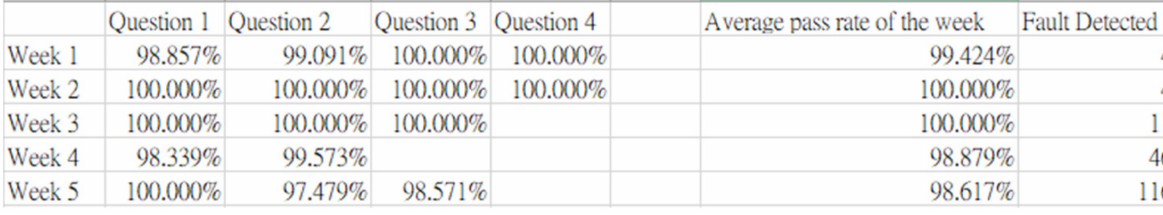
Figure 36. Correct-answer rate and average pass rate for assignments each week.